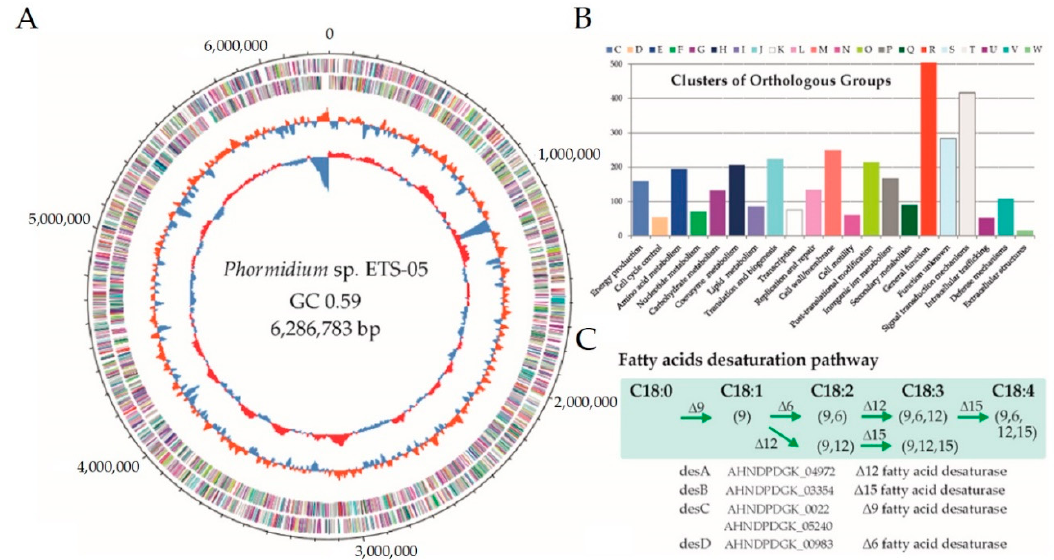
Figure 6. ( A ) Circular view of Phormidium sp. ETS-05 genome, showing from outside inward: (i) predicted coding sequences (CDSs) localized on forward / reverse strands and coloured according to the clusters of orthologous groups (COG), (ii) GC content (%), and (iii) GC skew. ( B ) Histogram reporting the number of genes assigned to each COG category. ( C ) Schematic representation of the manually-curated fatty acids pathway reporting the genes identified from the genome annotation.